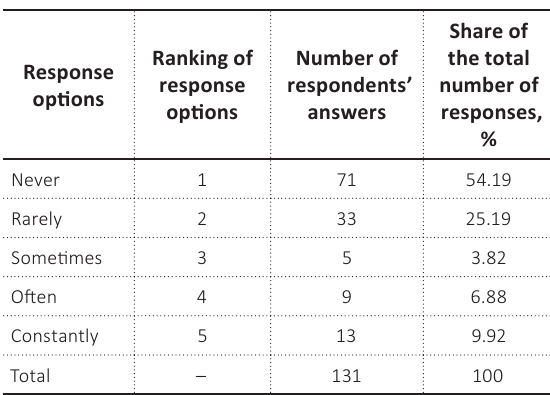
Source: Calculated by the authors.